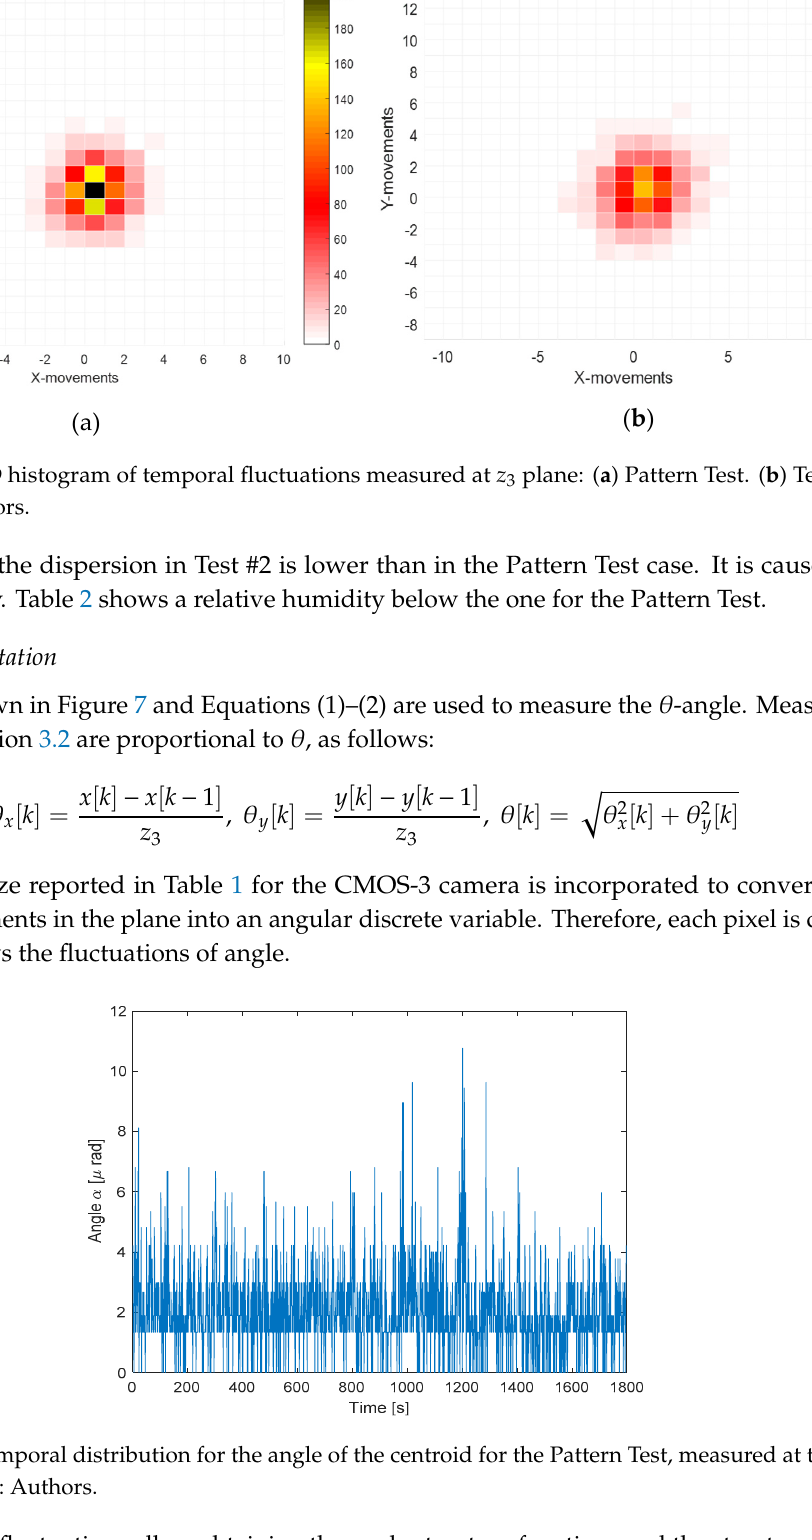
Figure 10. 2D histogram of temporal fluctuations measured at 𝑧 (cid:2871) plane: ( a ) Pattern Test. ( b ) Test #2. Source: Authors.